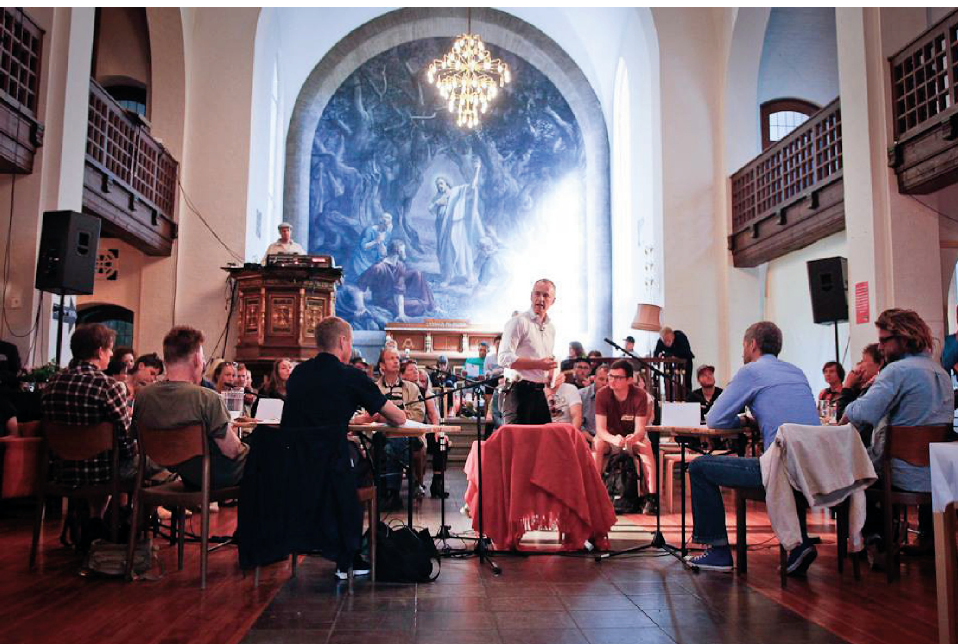
Figure 3. An advocate challenging a witness during a Free Trial! on social inclusion in May 2014. Source: Courtesy of Yann Houlberg